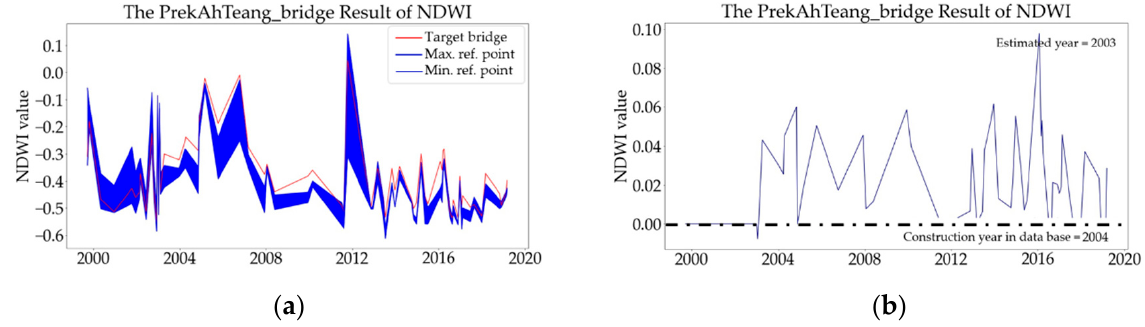
Figure 23. ( a ) NDWI results for the Preak Ah Teang bridge from which it is estimated that the bridge was constructed in 2003 based on the deviation of the target NDWI from the blue shaded region; ( b ) re-visualization of ( a ) showing the NDWI difference; a clear change is apparent.